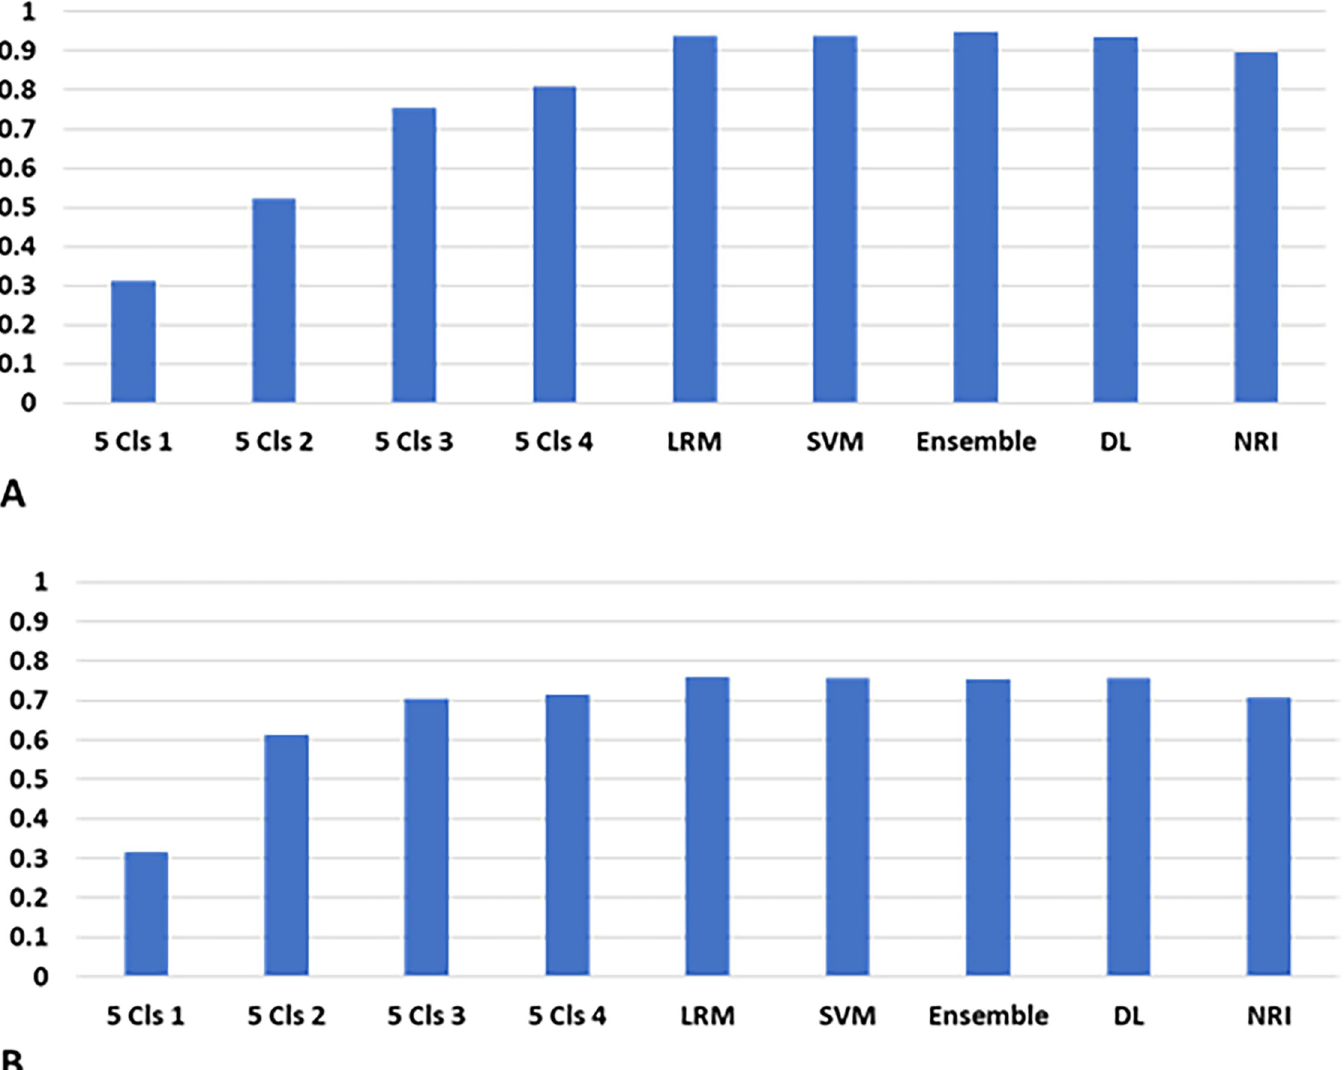
Fig 9. Accuracies of predicting 1-year and 5-year deaths. A. 1-year death. B. 5-year death. The accuracies of the models were evaluated using the validation dataset. Abbreviations: 5 Cls 1, the cutoff point was the first cluster of Cluster 5; LRM, multivariate logistic regression model; SVM, support vector machine; Ensemble, ensemble model of K-means method and SVM models; DL, deep learning model; NRI, nutritional risk index.